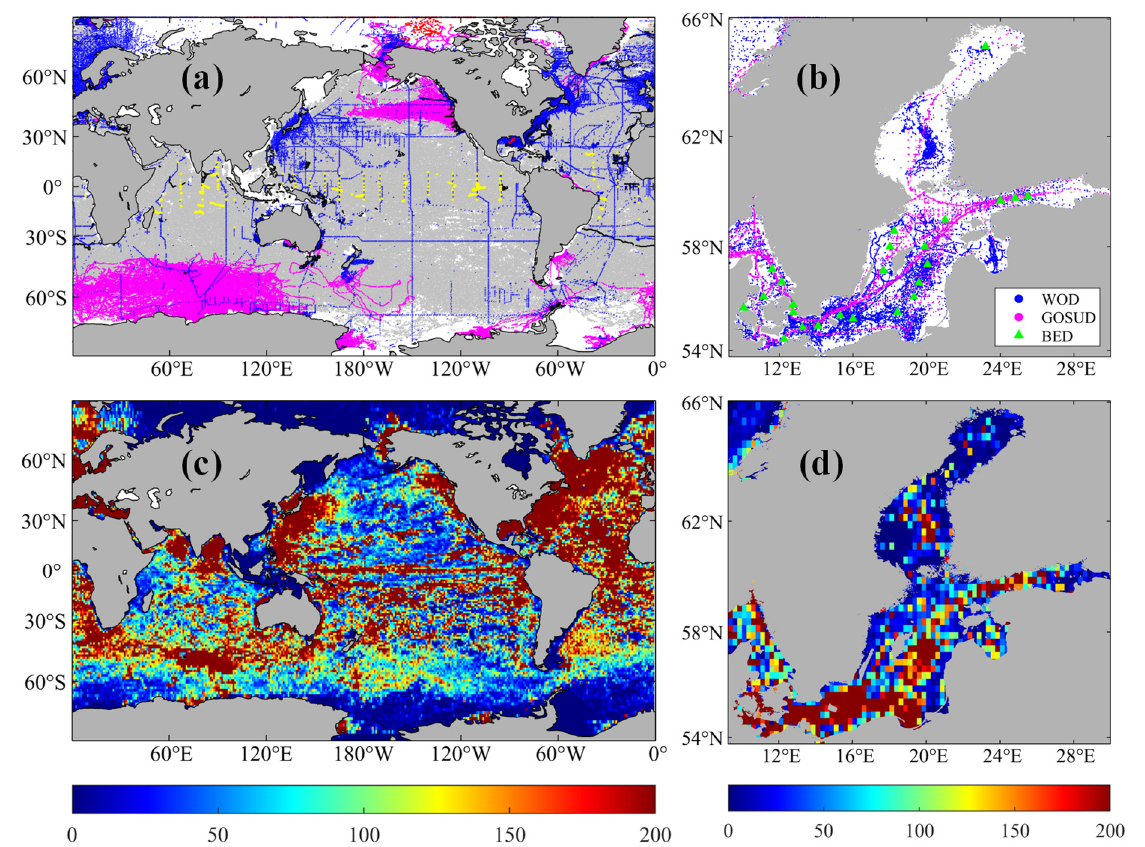
Figure 1. ( a ) Global distribution of in situ salinity data from the World Ocean Database (gray: Argo profilers, yellow: mooring buoys, blue: CTD, black: glider, red: drifting buoys, magenta: thermosalinograph). ( b ) Regional distribution of in situ salinity data in the Baltic Sea as provided by the GOSUD (magenta), the World Ocean Database (blue) and the Baltic Environmental Database (green). The bottom panels show the corresponding data volume of ( c ) the global WOD data at 1° boxes and ( d ) multi-source salinity measurements in the Baltic Sea at 0.25° boxes.